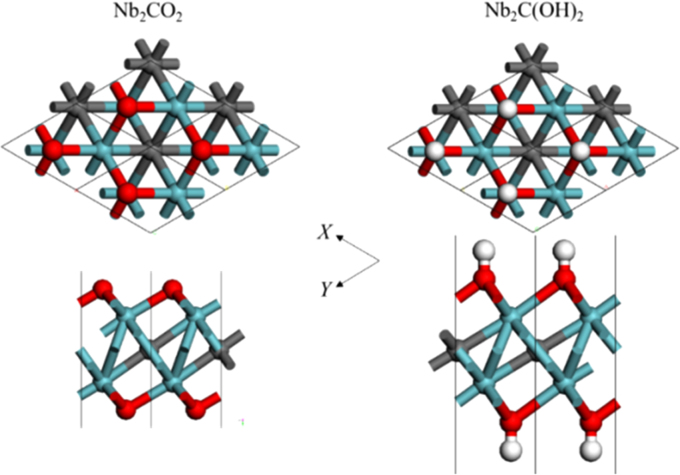
Top views and side views from the X direction of the optimal structures of Nb2CO2 and Nb2C(OH)2. The atoms represented by different color balls are the same as in Fig. 2.